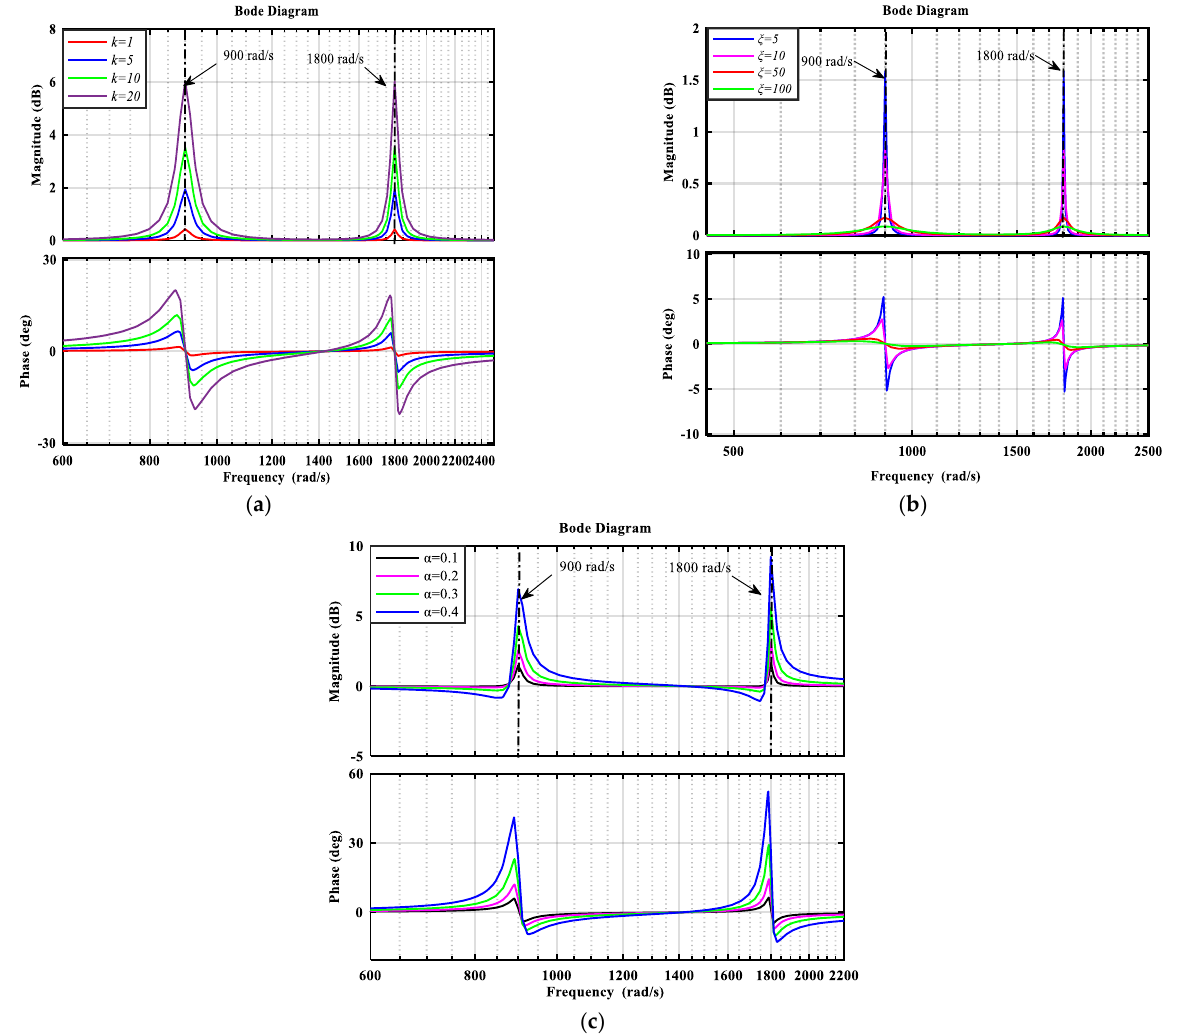
Figure 3. Bode diagram of 1 + H ( s ) : ( a ) increasing k with constant ξ = 10 rad/s and α = 0.1, ( b ) increasing ξ with constant k = 10 and α = 0.1, and ( c ) increasing α with constant k = 5 and ξ = 10